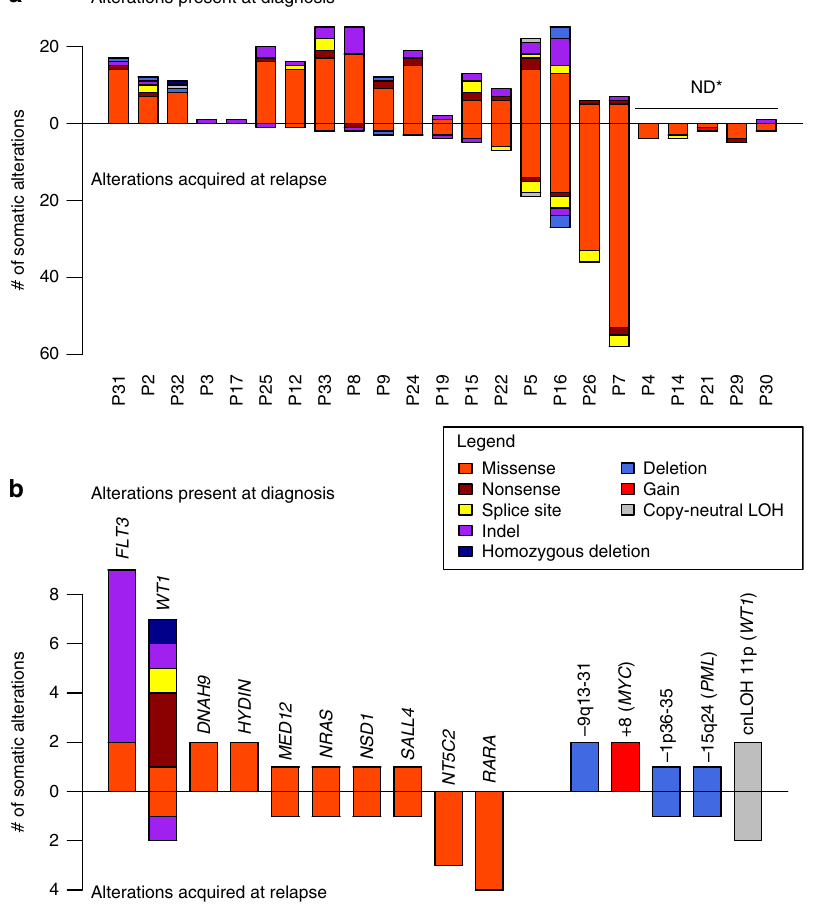
Fig. 1 Graphic summary of the exome analysis of relapsing APLs. a Number and type of somatic alterations identi fi ed at diagnosis (upper part) and acquired at relapse (lower part) for each patient. ND* indicates sample pairs with no available remission germline DNA, precluding determination of diagnostic alterations. b Somatic mutations (left) and copy-number alterations (right) observed at diagnosis (upper part) or relapse (lower part) at least twice in the study. Note the unexpected high prevalence and molecular variety of WT1